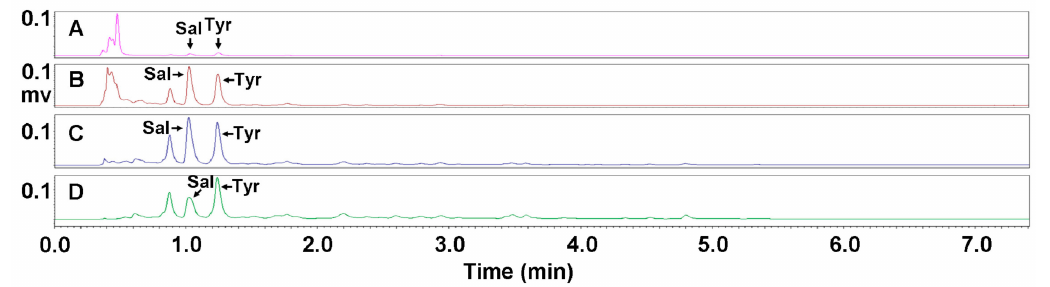
Figure 3. UPLC profiles for the purification of the salidroside and p -tyrosol by 5%, 10%, 15%, and 20% ethanol with DIAION HP-20 adsorbent resin. Shown in sequence are profiles of 5% ethanol eluent ( A ), 10% ethanol eluent ( B ), 15% ethanol eluent ( C ), 20% ethanol eluent ( D ). Sal and Tyr refer to salidroside and p -tyrosol,